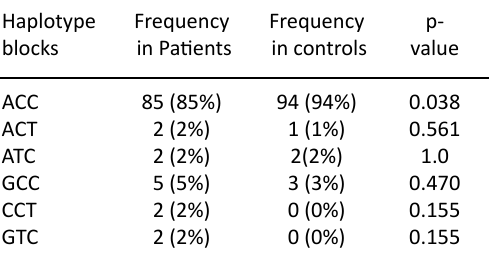
Table 6. Haplotype blocks of TLR-4 polymorphism in patients and controls